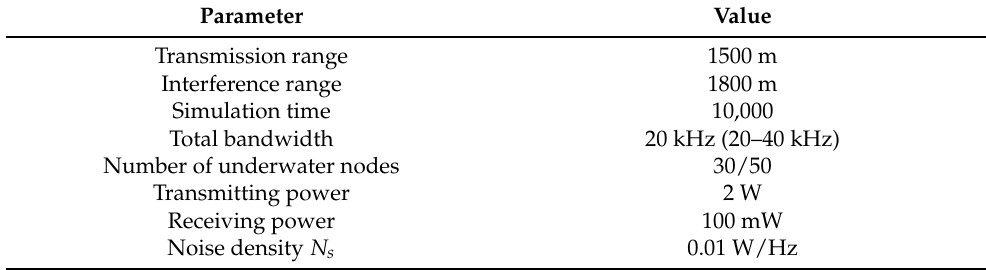
Table 2. Simulation